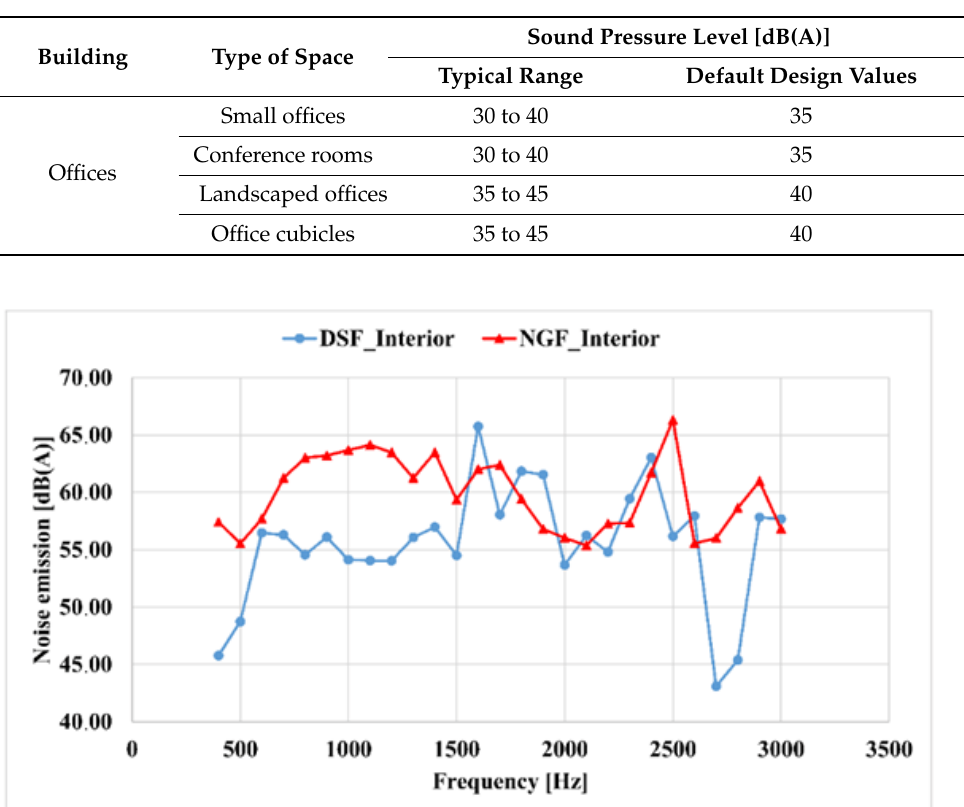
Figure 6. Comparison of the noise level inside the double-skin façade interior room and normal window interior room, frequency interval 400–3000 Hz.